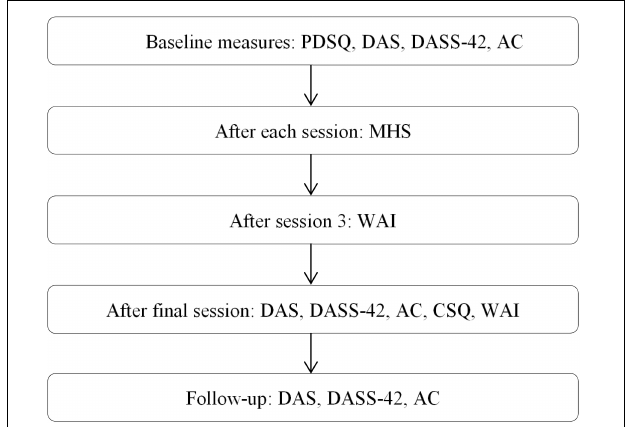
FIGURE 2 | Flowchart of measures given to participants throughout the study. PDSQ, Psychiatric Diagnostic Screening Questionnaire, DAS, Dyadic Adjustment Scale, DASS-42, Depression, Anxiety and Stress Scale-42, Ac, Areas of Change Questionnaire, MHS, Marital Happiness Scale, WAI, Working Alliance